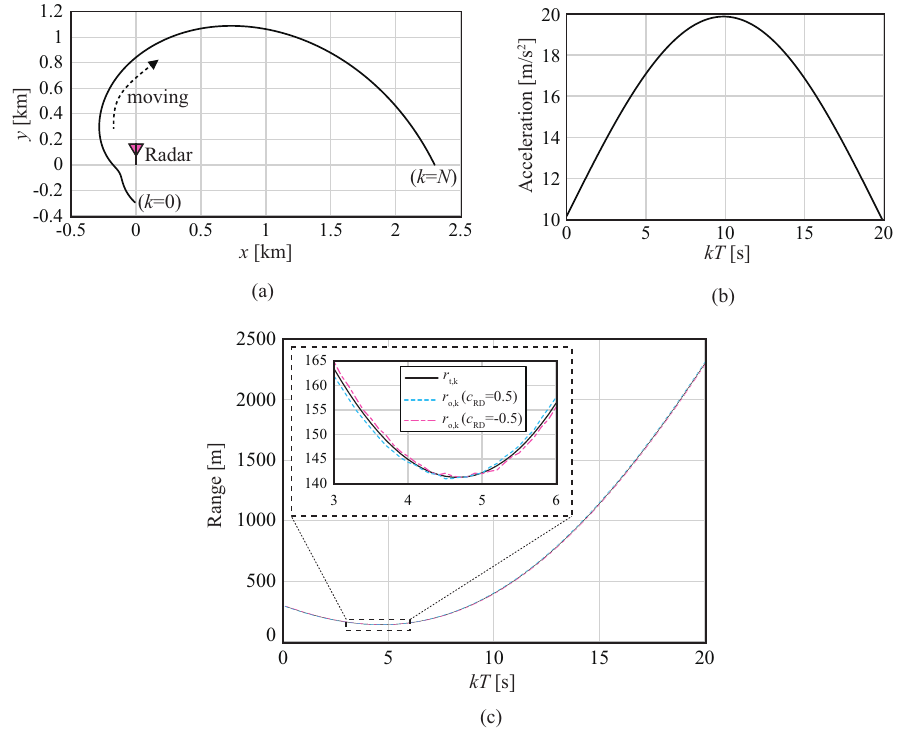
Figure 3. Simulation scenario. ( a ) true orbit of the target and radar position; ( b ) true acceleration of the target; and ( c ) true and measurement range for c RD = ± 0.5.